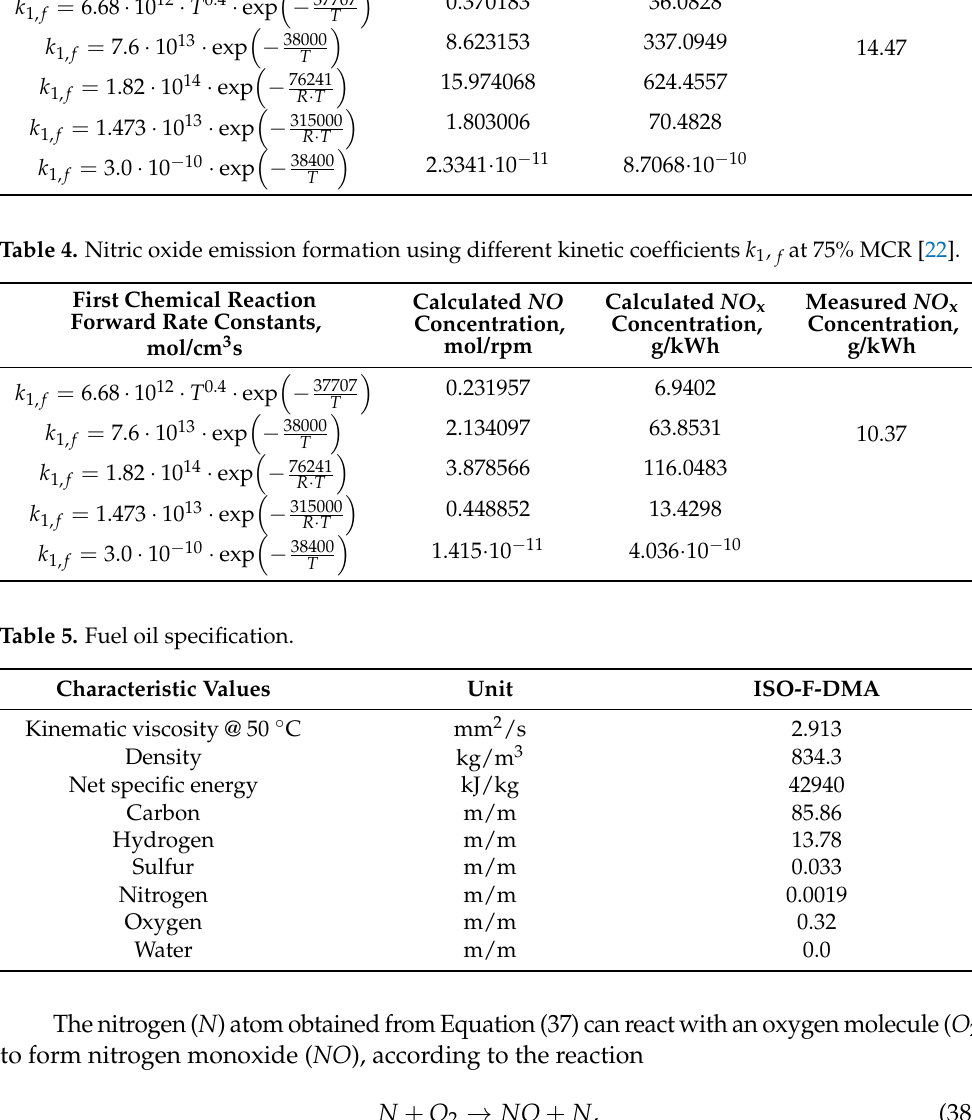
Table 3. Nitric oxide emission formation using different kinetic coefficients k 1 , f at 50% MCR [22]. First Chemical Reaction Calculated NO Forward Rate Constants, Concentration, mol/cm 3 s